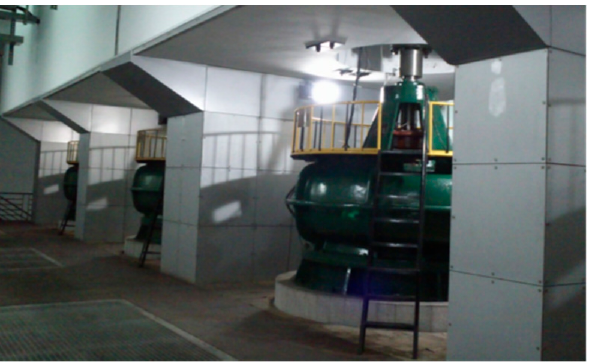
Figure 13. Schematic diagram of the pumping unit of a medium-sized pumping station.